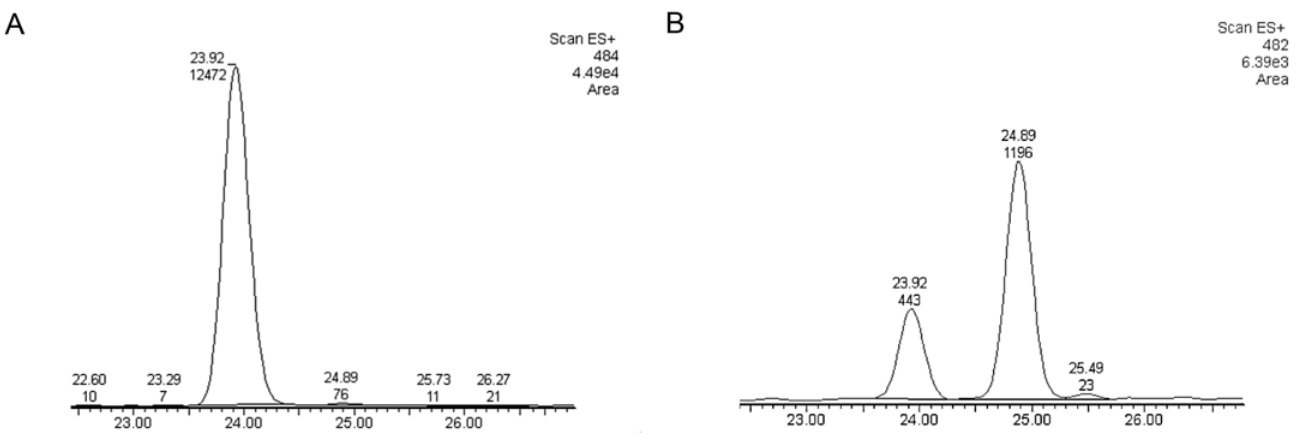
Fig 4. Extracted ion chromatograms from HPLC-MS analysis of CLas(+) and CLas(-) D . citri methanol extracts. A) diaphorin (484 m/z ) and B) novel predicted polyketide (482 m/z ). Retention time (minutes) on the X axis, signal intensity on the Y axis with peak area integration indicated above spectral